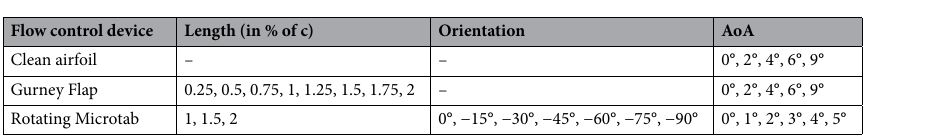
data. As the results demonstrate, the results obtained with the fine mesh are close to the experimental ones, and the convergence criteria is fulfilled, which means that the mesh is suitable for these simulations. Two different flow control devices were added to the TE of the airfoil: Gurney flaps and rotating microtabs. A total of 48 different cases with Gurney flaps were considered, with different lengths and angles of attack; and 105 different cases with rotating microtabs, with different lengths (L), orientations (β) and angles of attack. The remaining five cases consist of the airfoil without flow control devices. All the studied cases are summarized in Table 2. These flow control devices were added to the previously-explained mesh by the cell-set model. This modelling technique consists of defining a geometry on an already-generated mesh, and then, splitting this geometry into a new region, and defining it as wall with no-slip conditions. As demonstrated by Ballesteros-Coll et al. 6 , this model is suitable for this kind of problems, since a global relative error of 3.784% of this model in comparison with the fully-resolved model was obtained in that study. Figure 3 illustrates an example of the cell-set model implementation for a rotating microtab. − 5 Pa · s Regarding the fluid physics, the dynamic viscosity of the air was set at µ = 1.855 · 10 , and the density was set at ρ = 1.2041kg/m 3 . The freestream velocity of the flow was set at U ∞ = 30m/s , which means that the Reynolds number (Re) is equal to 2 · 10 6 . For turbulence modelling RANS-based k-ω Shear Stress Transport (SST) model by Menter 28 was chosen, which combines the k-ω model for the near-wall zones and k-ε model for the regions far from the walls. UpWind algorithm was employed for the pressure–velocity coupling and a linear upwind second order scheme was used to discretize the mesh. Convolutional neural network. Input and output layers. The domain is represented by four different 128 × 256 layers. The first two layers represent the geometry of the airfoil and the flow control device, and the other two layers represent the velocity components in both directions. The layers describing the domain are generated by means of a binary representation, where the points belong- ing to the geometry are identified with a 1 and those which do not belong to the geometry are identified with a 0. One of these layers provides an overview of the airfoil, while the other provides a close-up view of the airfoil TE, showing the flow control device in detail. Figure 4a shows the zones represented by each layer, and Fig 4b,c display and example of these two layers. The velocity layers provide the value of the velocity components. These layers are used to determine the AoA of the airfoil accurately, since in the above-explained binary-representation layers, slight variations in orientation